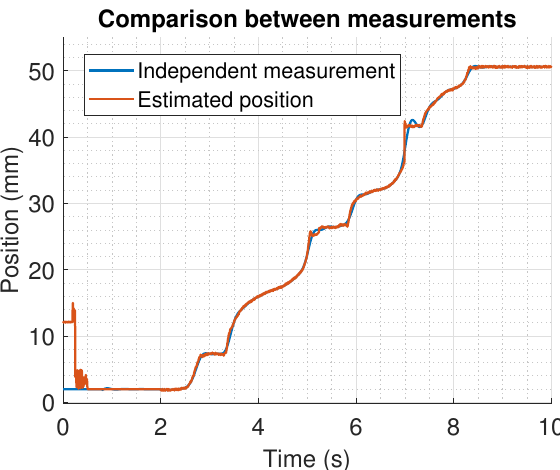
Figure 17. Estimated position with the proposer algorithm and a direct measurement obtained with a linear movement potentiometer.